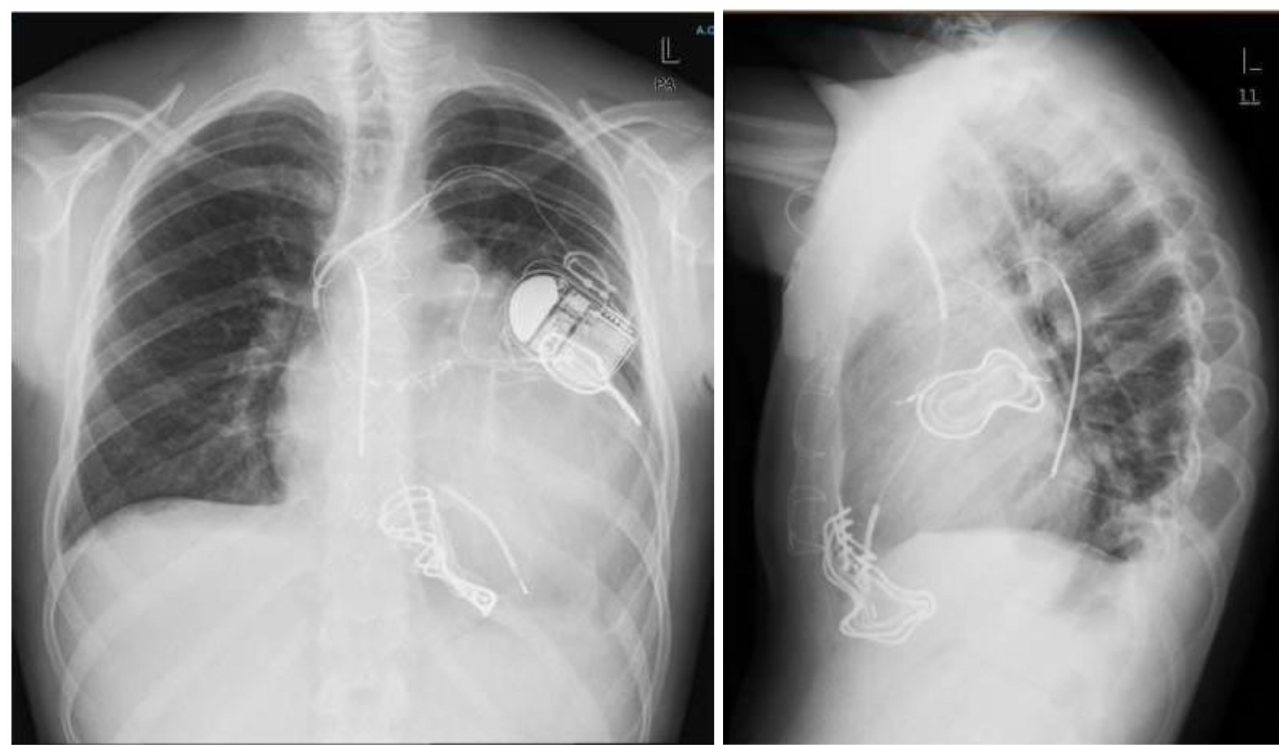
Figure 3. Lateral (left panel) and AP (right panel) chest X-ray after azygous vein ICD lead implantation. The shock pathway was formed by the old endocardial distal coil; the new floating coil was placed in the azygos vein and the